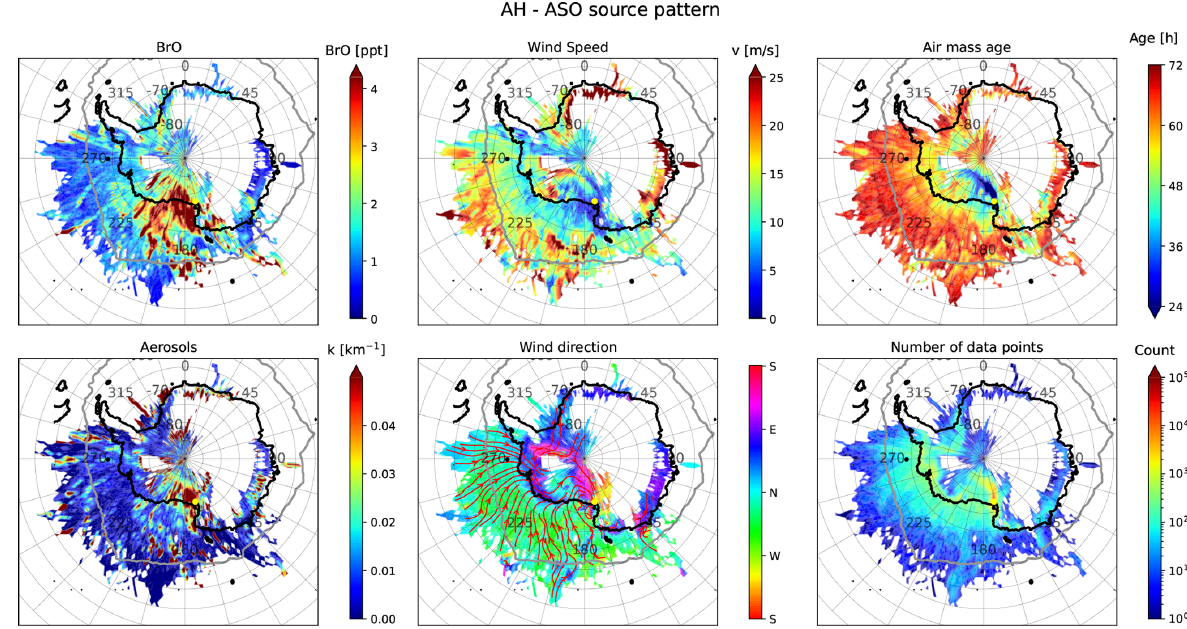
Figure 13. The same as Fig. 12 but for AH. Note the different colour scales for BrO and aerosols.